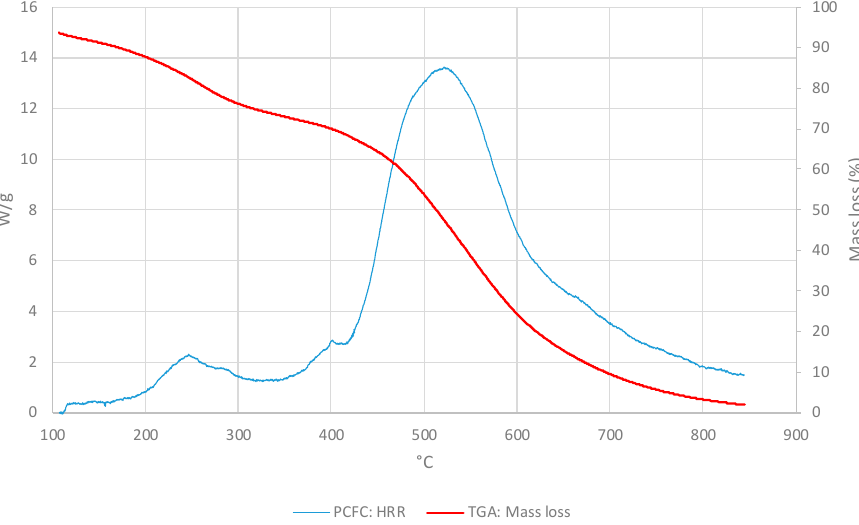
Figure 8. Values of the HRRs (W / g) and mass loss (wt.%) for layer IM.